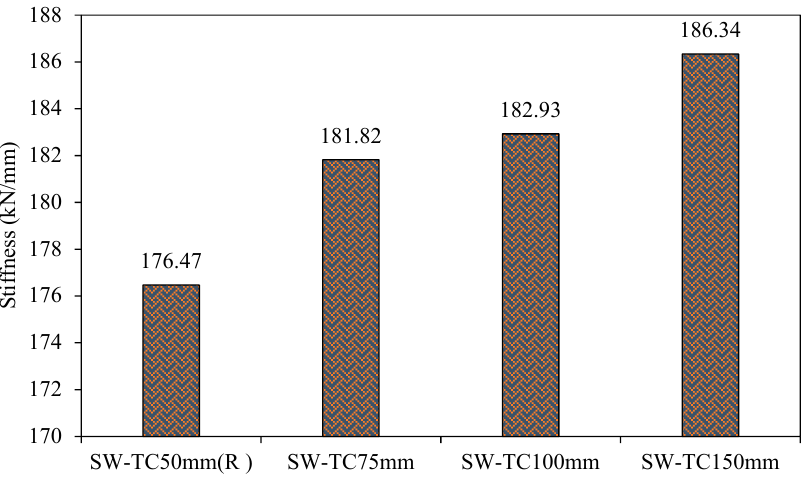
Figure 21. Stiffness of group 3.